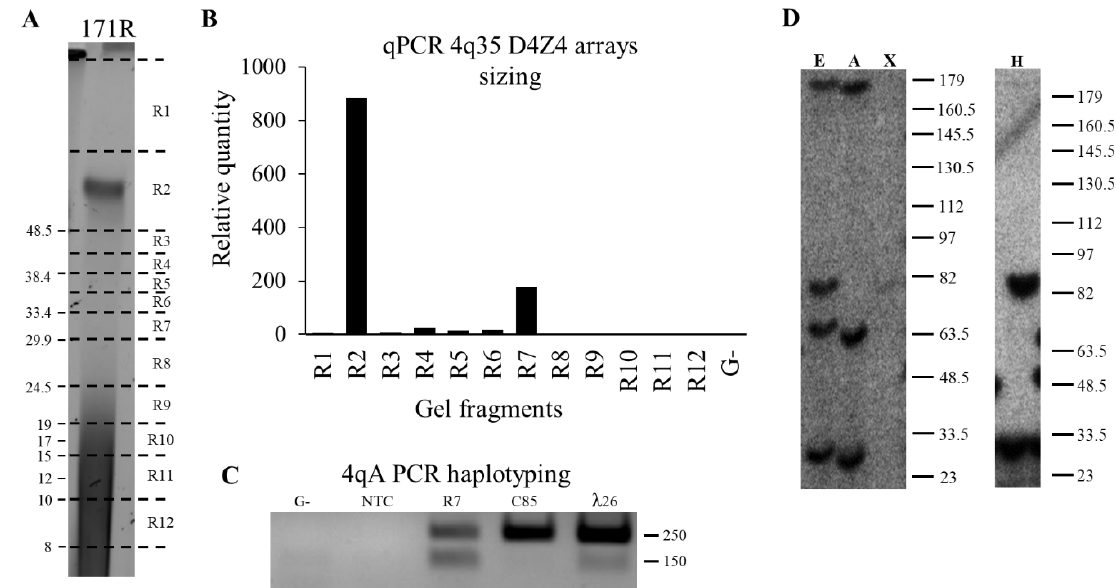
Figure 3. Results of the FSHD1 diagnostic test for patients. ( A ) PFGE results of the DNA sample of patient 171. Gel line 171R— Eco RI digested sample. The line 171R was manually fragmented; the gel fragment borders are indicated by a horizontal dotted black line. The gel fragment order is indicated on the right. The molecular weight marker scale is indicated on the left. ( B ) qPCR data were obtained using the gel fragments as a template. “G-” is negative gel control from the out-off sample’s line zone; R1–R12 correspond to gel fragments from R1 to R12. Based on the qPCR results, patient 171 had two 4q35 D4Z4 arrays in gel fragments R2 (normal size array, >48.5 kb) and R7 (contracted array up to 7 D4Z4 repeats). ( C ) PCR haplotyping results. NTC—negative control without agarose gel; G—-control of agarose gel contamination using G- gel fragment as a PCR template; R7—result obtained using the gel fragment R7 as a PCR template; C85—result obtained using 10 pg of cosmid C85 as a PCR template, control sample of the 10qA haplotype; λ 26—result obtained using 10 pg of cosmid λ 260201 as a PCR template, control sample of the 4qA haplotype. ( D ) Southern blotting results of patient 171’s DNA sample. On the left—results of hybridization with the p13e11 probe for D4Z4 arrays sizing and chromosome affiliation. A— Eco RI digested sample. E— Eco RI/ Avr II digested sample. X— Xap I digested sample. On the right—results of hybridization with the A probe for D4Z4 arrays haplotyping. H— Hind III digested sample. The molecular weight marker scale is indicated on the right of each blot